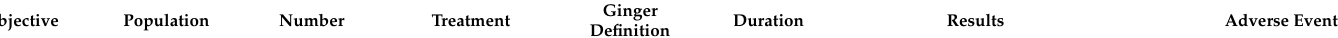
Table 9. Randomized double-blind trials investigating the effectiveness and safety of ginger for